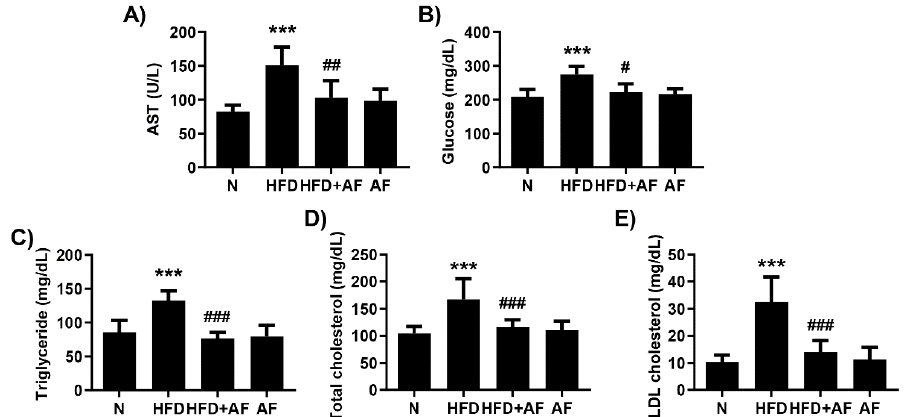
Figure 2. Auranofin improves HFD-induced suppression of the hepatic function and lipid accumulation in serum. Following treatment with or without HFD and auranofin for 8 weeks, the blood was collected, and the serum was analyzed. ( A – E ) The serum analysis results are expressed in the graph. Data are expressed as the mean ± SD ( n = 8). *** p < 0.001 compared with the normal group. # p < 0.05, ## p < 0.01, and ### p < 0.001 compared with HFD group. N, normal group; HFD, HFD fed group; HFD + AF, HFD fed and auranofin injection group; AF, auranofin injection